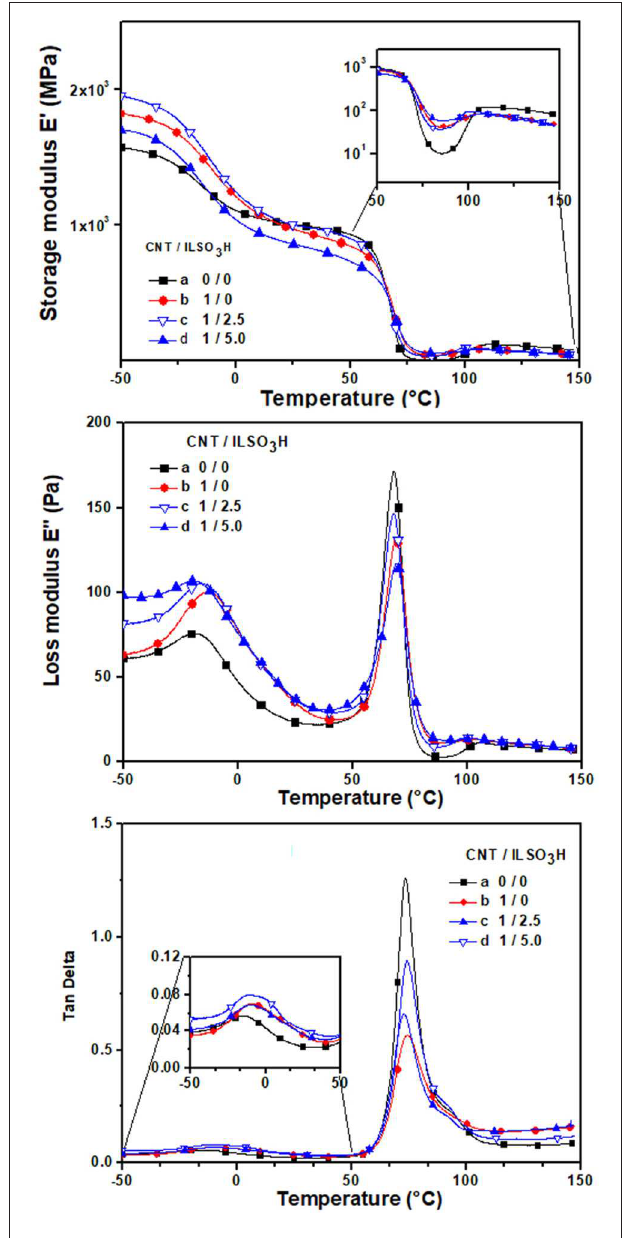
FIGURE 7 | Dynamic mechanical parameters as a function of the temperature for PLA/EVA blend containing CNT/ILSO 3 H in a proportion of (a) 0:0; (b) 1:0; (c) 1:1.25; and (d) 1:5